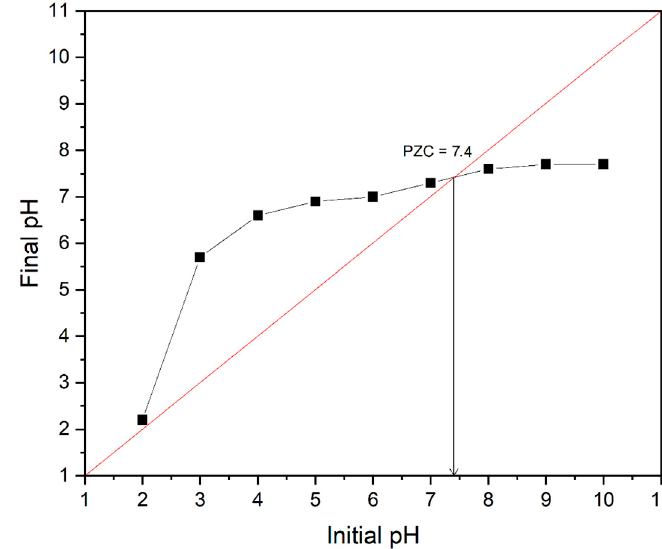
Figure 2. Point of zero charges of CPSMNPS adsorbent.